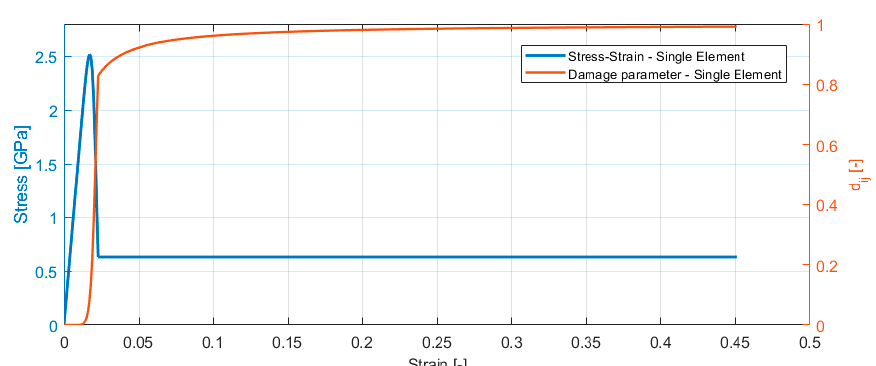
Figure 3. Stress–strain representative curve of uniaxial MAT58 single FE under fiber-aligned tensile load; associated damage parameter evolution coupled with the failure initiation and final erosion .